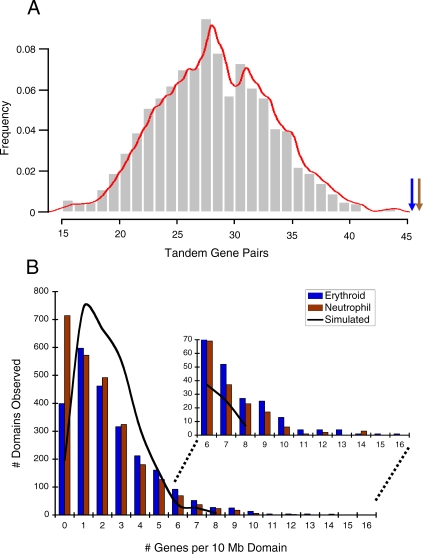
Co-Regulated Erythroid and Neutrophil Genes Are Proximal along Chromosomes(A) The bar graph represents the number of tandem gene pairs from the simulation (Materials and Methods), with a red trend line indicating a Gaussian distribution. The blue arrow indicates the 48 gene pairs found in the erythroid co-regulated gene set, and the brown arrow indicates the 49 neutrophil tandems (χ2, p < 0.0001). The gene sets are also enriched for triplets (χ2, p < 0.02).(B) We compared the distribution of the lineage-co-regulated genes to the simulated dataset by sliding-window analysis, with a 10-Mbp window moved in 1-Mbp steps through the genome. A proportions test indicates a significant difference between the lineage and the microarray gene distributions (p < 1.2 × 10−05), but not between the simulated and microarray (p < 0.22). The simulated dataset, represented as a black line, yields a Gaussian distribution. The inset reveals that the lineages have more gene-dense domains than the simulated dataset.